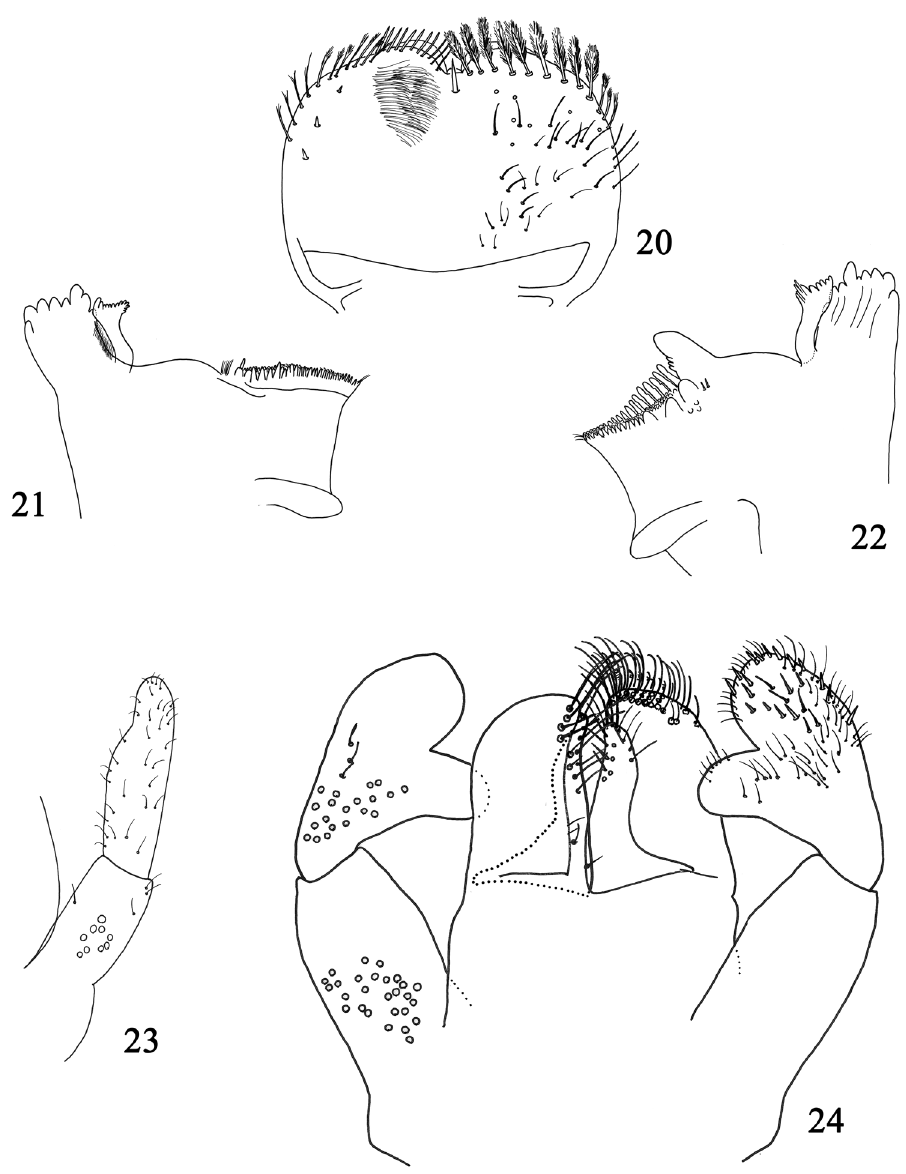
Figures 20–24. Larval structures of Labiobaetis alahmadii sp. n.: 20 labrum (left : ventral; right: dorsal) 21 right mandible 22 left mandible 23 detail of maxilla 24 labium.